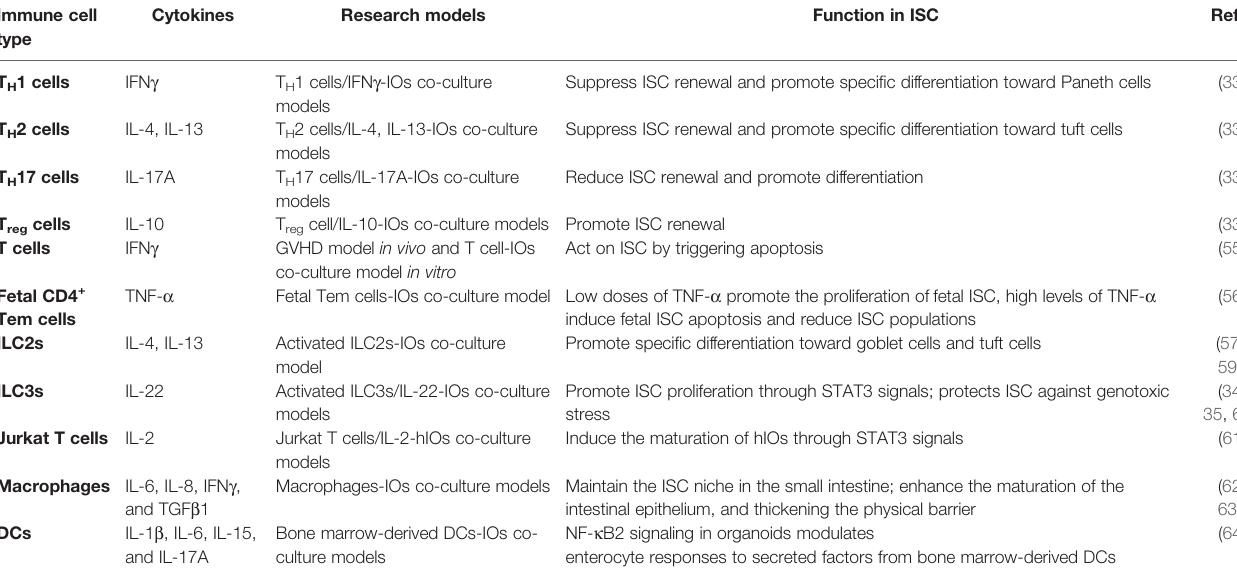
TABLE 1 | The link between the intestinal stem cells and immune cells. Immune cell